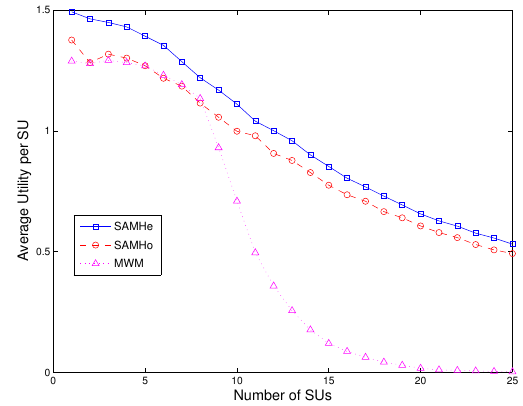
Figure 2: Average utility per SU. SAMHe and SAMHe both show a steady decrease in average util- ity. MWM however drops very sharply from the initial values after 8 SUs.